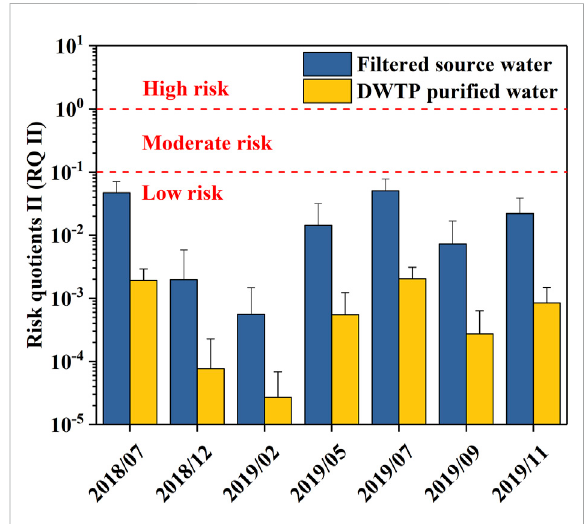
FIGURE 6 RiskquotientII(RQII)fortheassessmentoftheriskto human health by organotin compounds (OTCs) from the fi ltered source water and treated water from the drinking water treatment plant